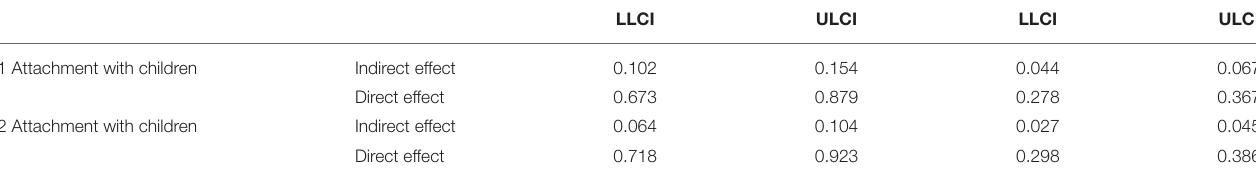
TABLE 6 | Bootstrap analysis results for the mediating effect.